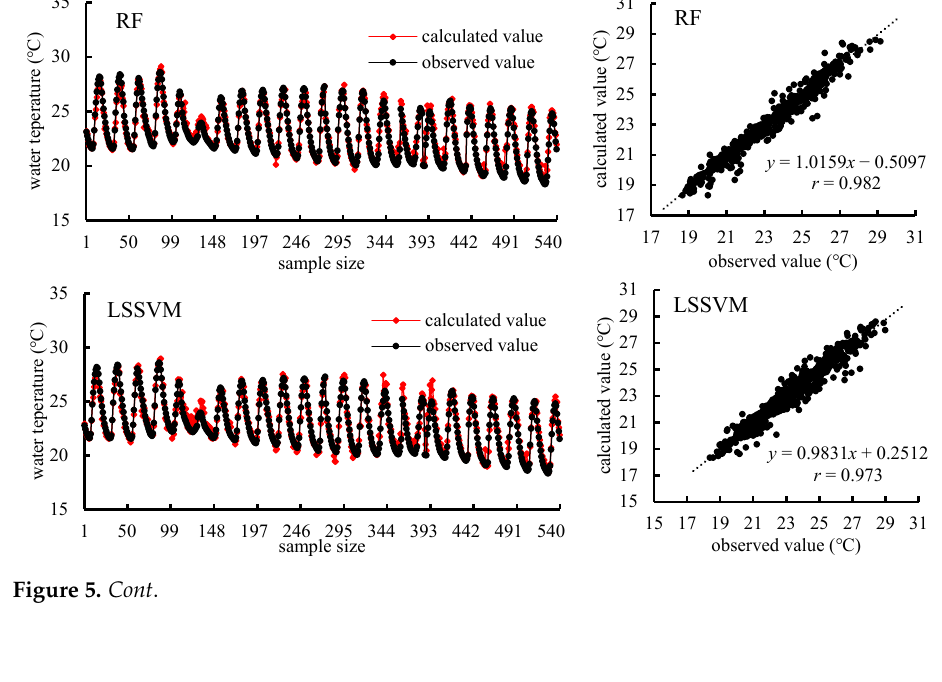
Figure 5. Dynamic curve and relationship between observed value and calculated value of hourly water temperature. The r, RMSE, NSE and MAE are used to compare the model simulation results; then, the best machine learning algorithm for water surface temperature prediction in the study area is analyzed.